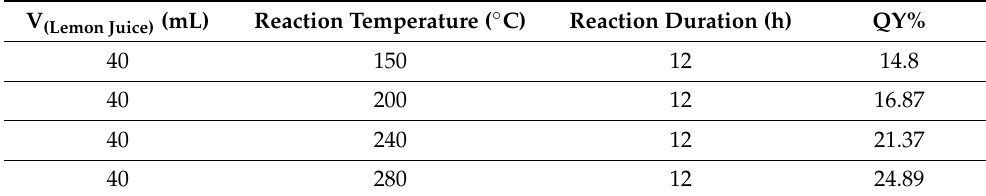
Quantum yield values of hydrothermally prepared GCDs under different temperature conditions